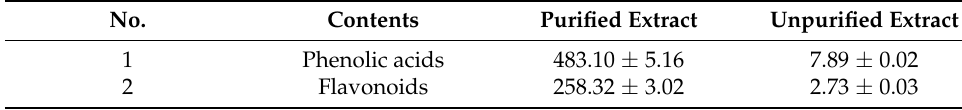
Table 7. Phenolic acids and flavonoid contents ( µ g/mg dw).